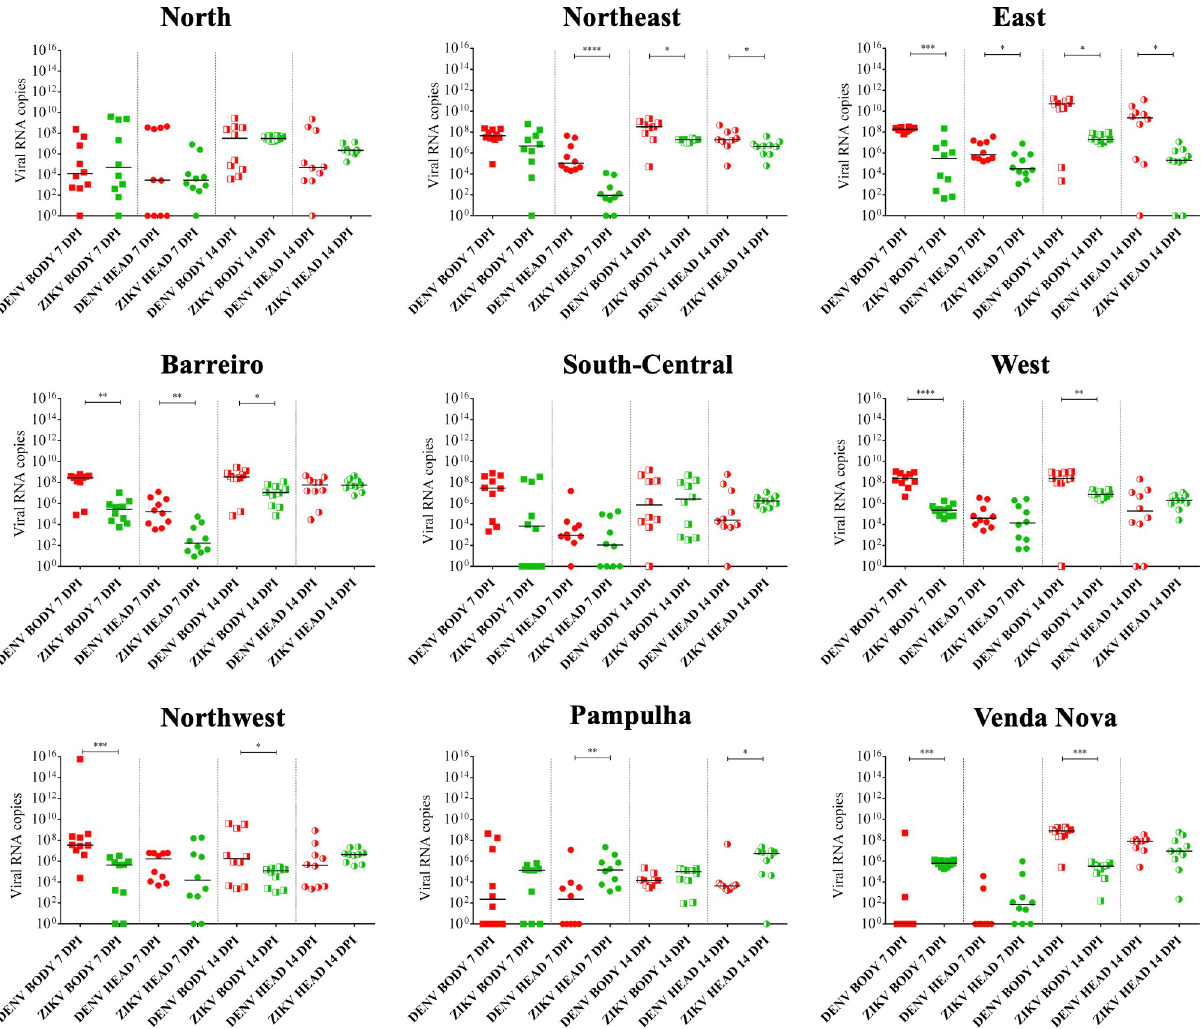
Fig 6. Representation of DENV (red) and ZIKV (green) viral load comparisons for each of the nine Ae . aegypti populations of Belo Horizonte. Fully filled and half-filled squares represent viral load in the mosquito bodies at 7 and 14 dpi, respectively. Fully filled and half-filled circles represent viral load in the mosquito head/SG at 7 and 14 dpi, respectively. P values > 0.05 (not significative) are not represented. P values � 0.05, � 0.01, � 0.001, � 0.0001 are summarized with one, two, three, and four asterisks, respectively. The p-values of the comparisons between body 7 dpi, head 7 dpi, body 14 dpi, head 14 dpi were, respectively: 0.7004, 0.9109, > 0.9999, 0.1419 (North); 0.0887, ���� < 0.0.0001, � 0.0133, � 0.0349 (Northeast); ��� 0.0003, � 0.115, � 0.0232, � 0.0286 (East); �� 0.0021, �� 0.0011, � 0.0147, 0.7243 (Barreiro); 0.0703, 0.3484, 0.6706, 0.1419 (South-Central); ���� < 0.0001, 0.3867, �� 0.0015, 0.4237 (West); ��� 0.0003, 0.2399, � 0.0354, 0.1220 (Northwest); 0.7913, �� 0.0065, 0.3493, � 0.0185 (Pampulha); 0.0008, 0.0734, ��� 0.0003, 0.2341 (Venda